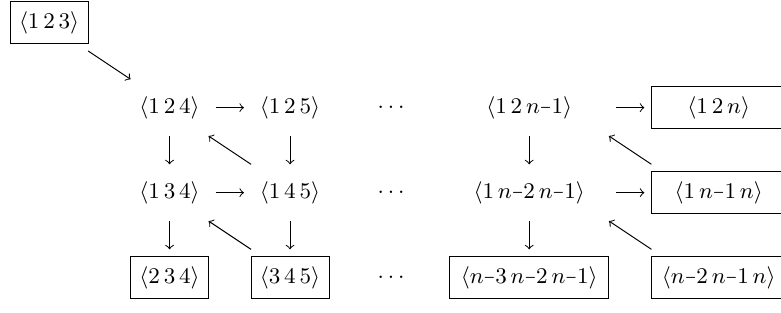
Figure 1. The initial cluster of the Grassmannian cluster algebra Gr(3 , n )